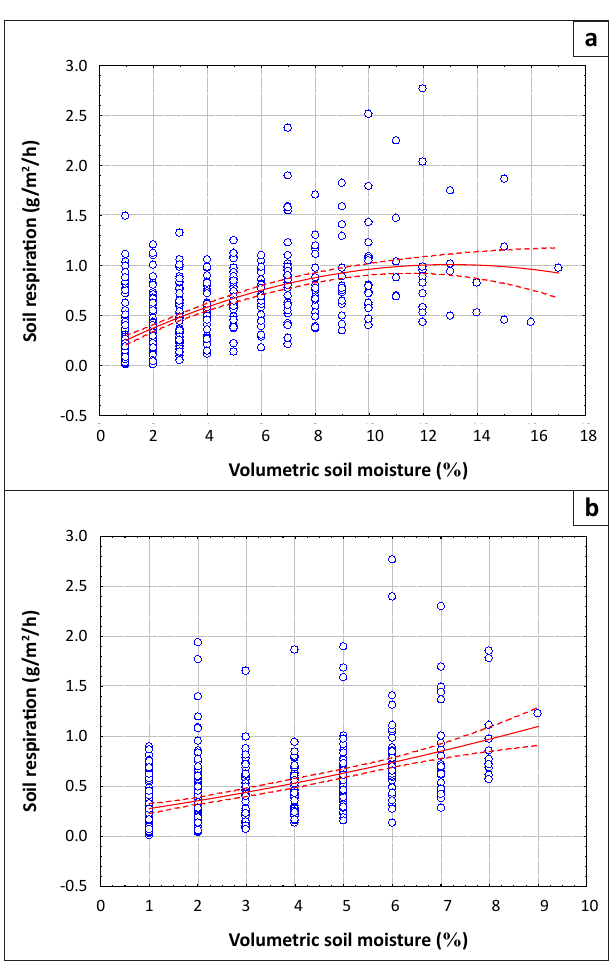
FIGURE 2: Effect of soil moisture on the rate of (a) respiration in the Acacia FIGURE 3: Effects of soil temperature and moisture on the rate of soil respiration savanna ( R 2 = 0.380) and (b) soil CO respiration in the Combretum savanna in the Acacia (a) and Combretum (b) savannas. Multiple regression [ R ( z/xy )] 2 ( R 2 = 0.259) . The dots are actual data and the solid line represents the fitted shows that soil moisture and temperature jointly explain a major fraction of the linear regression at the 95 % confidence interval (dashed lines). variation in respiration in the Acacia ( R = 0.647) and Combretum ( R = 0.636)